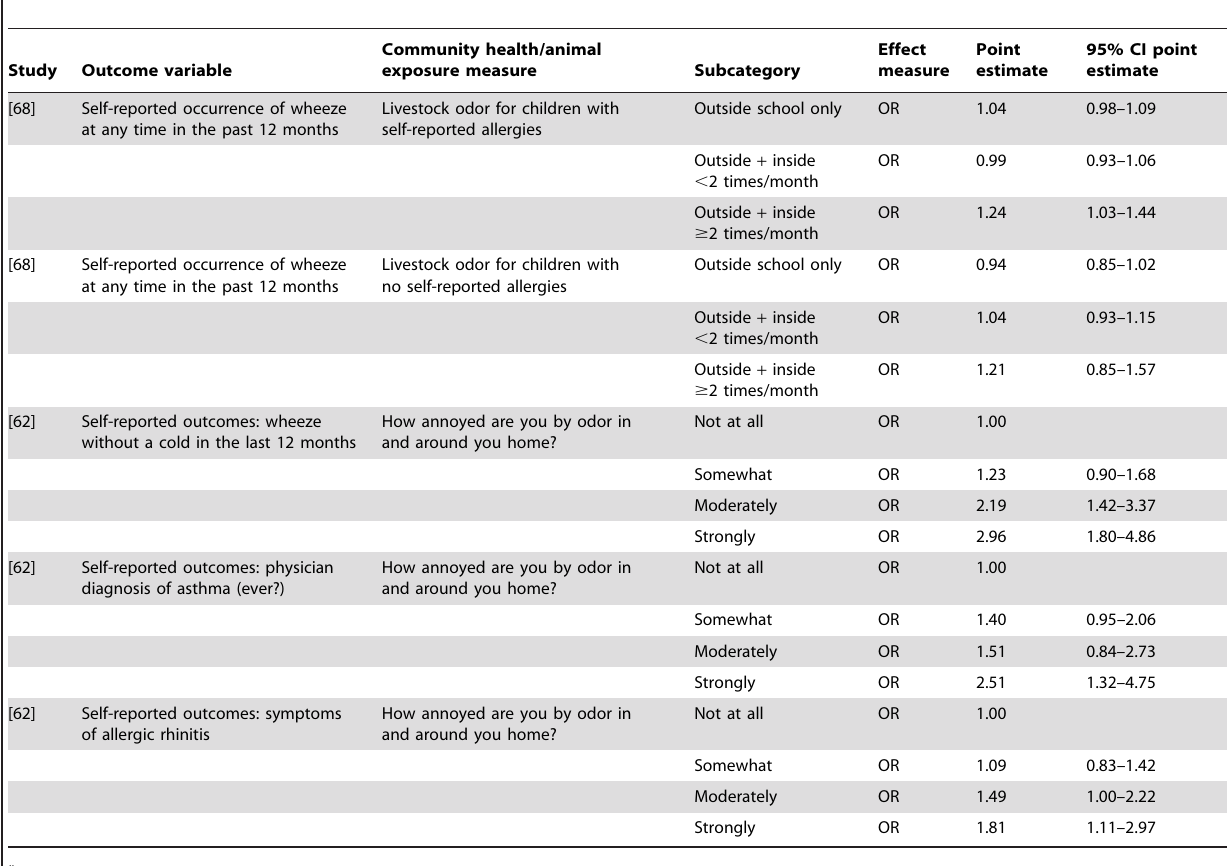
Table 5. The adjusted* association between the self-reported health outcomes and odor measures in communities near AFOs.